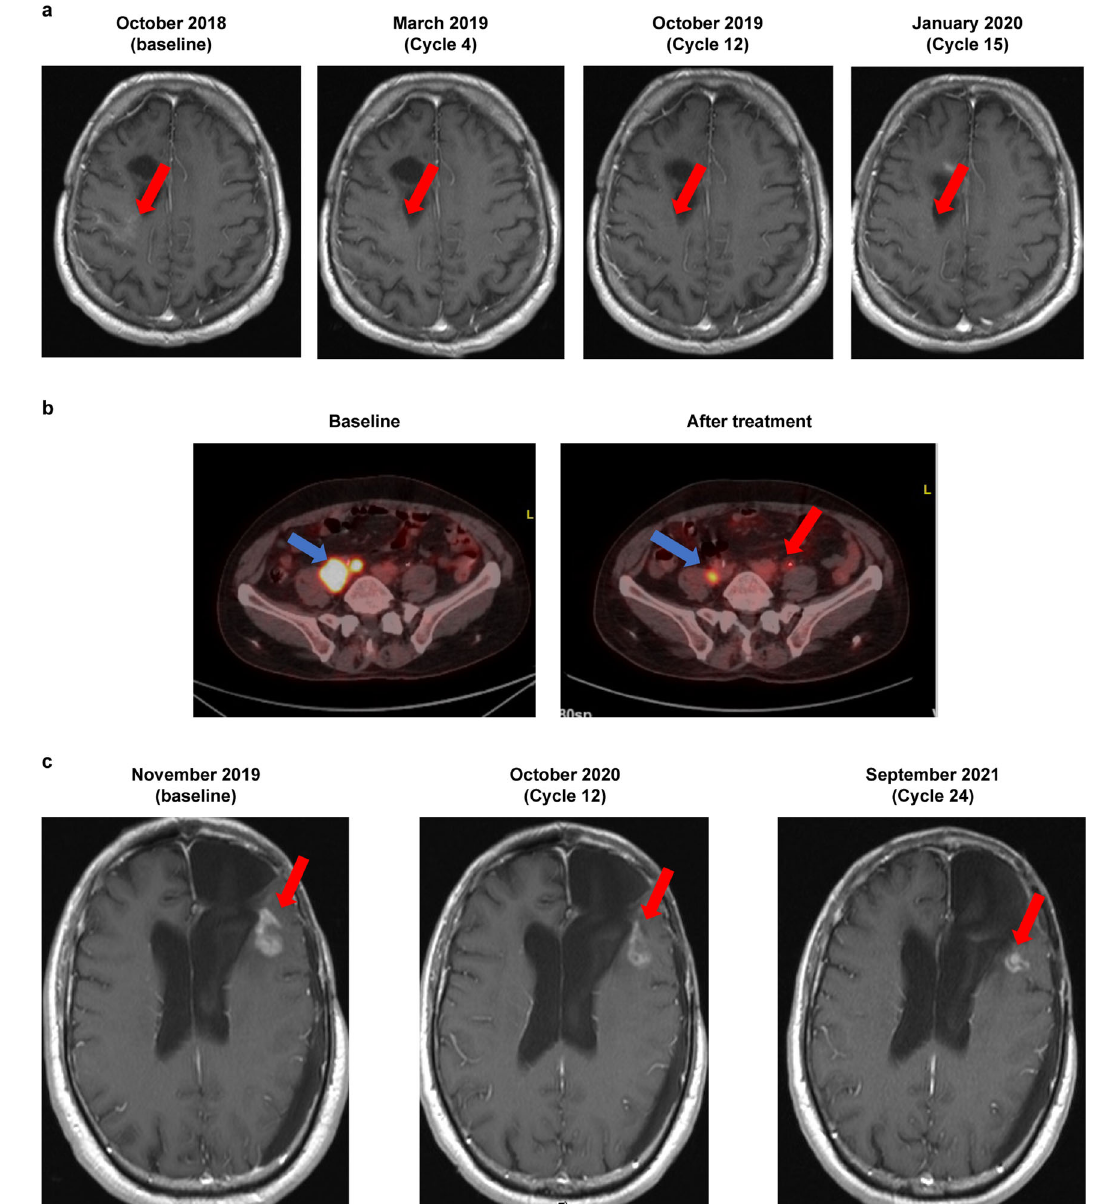
Fig. 5 | Imaging results of representative responses to trotabresib. a MRI eva- luation of a patient with grade 2 astrocytoma. The patient had a complete response on trotabresib (red arrows), with the disappearance of both enhancing and non-enhancing areas compared with baseline. The patient discontinued after 19 cycles of treatment due to disease progression. b FDG-PET/CT evaluation of a patient with germinal center B-cell immunophenotype R/R DLBCL who had a 57% reductionintargetlesionsizeaftertwo cyclesoftrotabresib(bluearrow).Thiswas accompanied by the appearance of a new metabolic lesion (red arrow), and treat- ment wasdiscontinued after four cycles of trotabresibdue to disease progression. c MRI evaluation of a patient with refractory high-grade astrocytoma. The patient